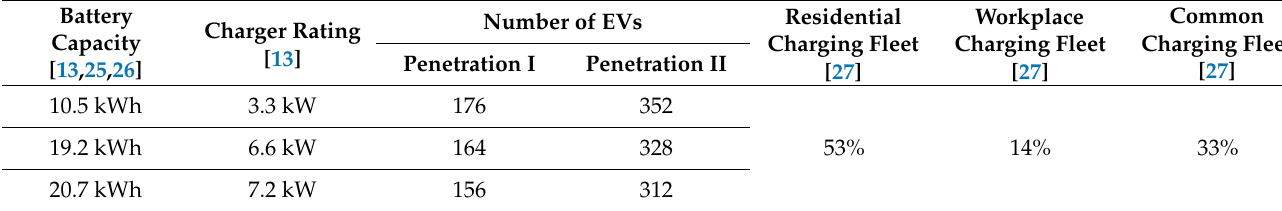
Table 2. EVs Fleet Specifications.